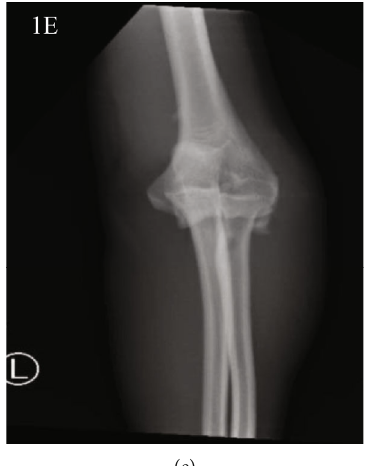
Figure 1: Left wrist PA (a), oblique (b), and lateral (c) injury radiographs along with left elbow lateral (d) and AP (e) injury radiographs. Left elbow posterior dislocation with fracture fragment along the anterolateral aspect of the elbow. Comminuted intraarticular left distal radius